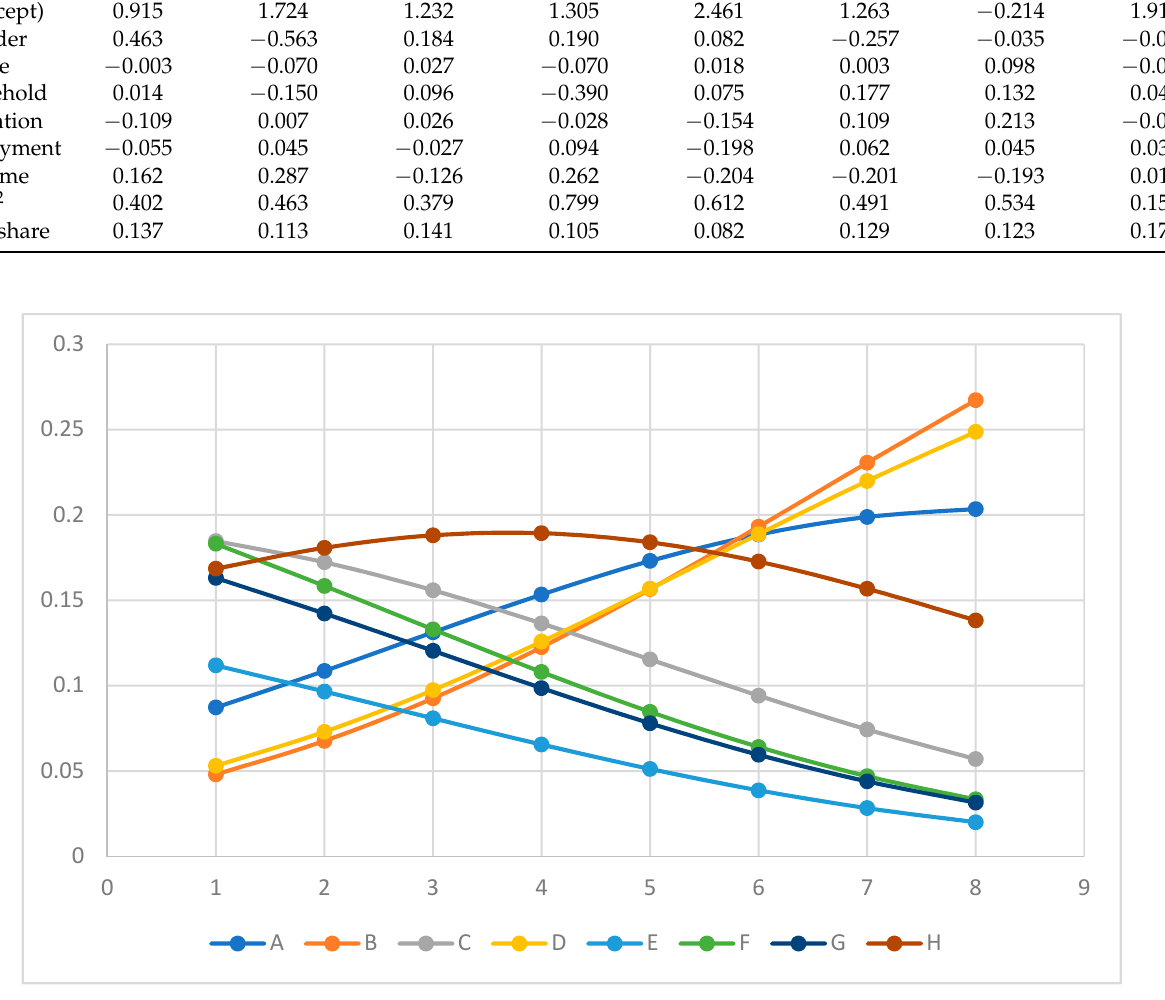
Figure 2. AHP eight flavors priorities profiled by income.